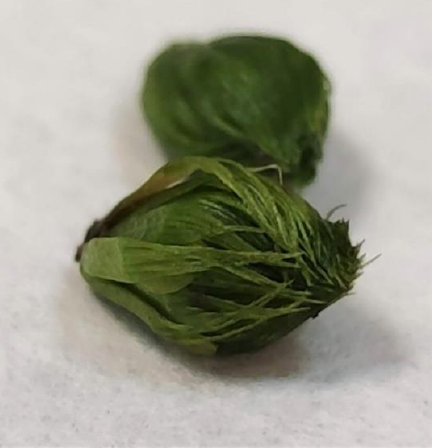
Figure 2. Turions of Aldrovanda vesiculosa used for tissue culture initiation.